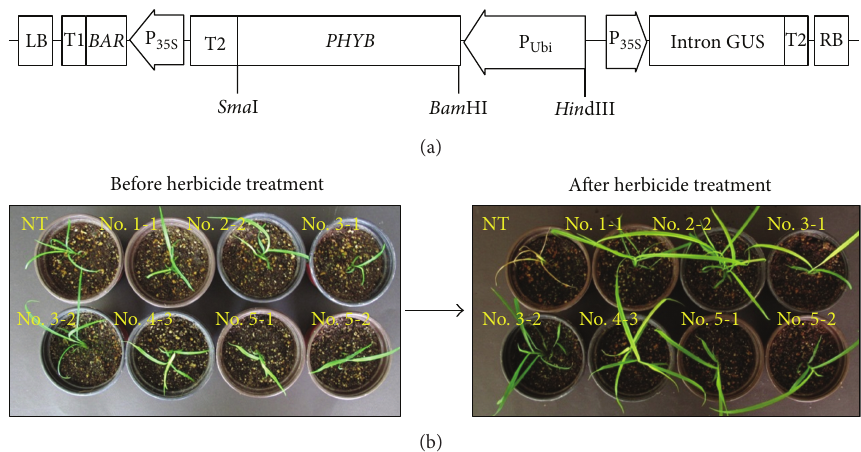
Figure 2: Construct for the transformation and herbicide resistance assay of putative transgenic plants. (a) T-DNA region of the binary vector plasmid pCAMBIA3301 harboring Arabidopsis PHYB gene. RB: right border; LB: left border; P 35 promoter; intron GUS: GUS coding region with catalase intron insertion; PHYB : full-length phyB gene of Arabidopsis ; BAR : phosphinotricin acetyltransferase gene coding region; T1: CaMV 35S gene terminator; T2: A. tumefaciens NOS gene terminator. Arrows indicate directions of transcription. (b) Herbicide resistance assay. Numbers in lanes represent putative transgenic plants selected for this analysis. 0.4% BASTA was sprayed onto nontransformed wild-type control plant (NT) and the transgenic plants, and the herbicide resistance of the plants was determined 14 days